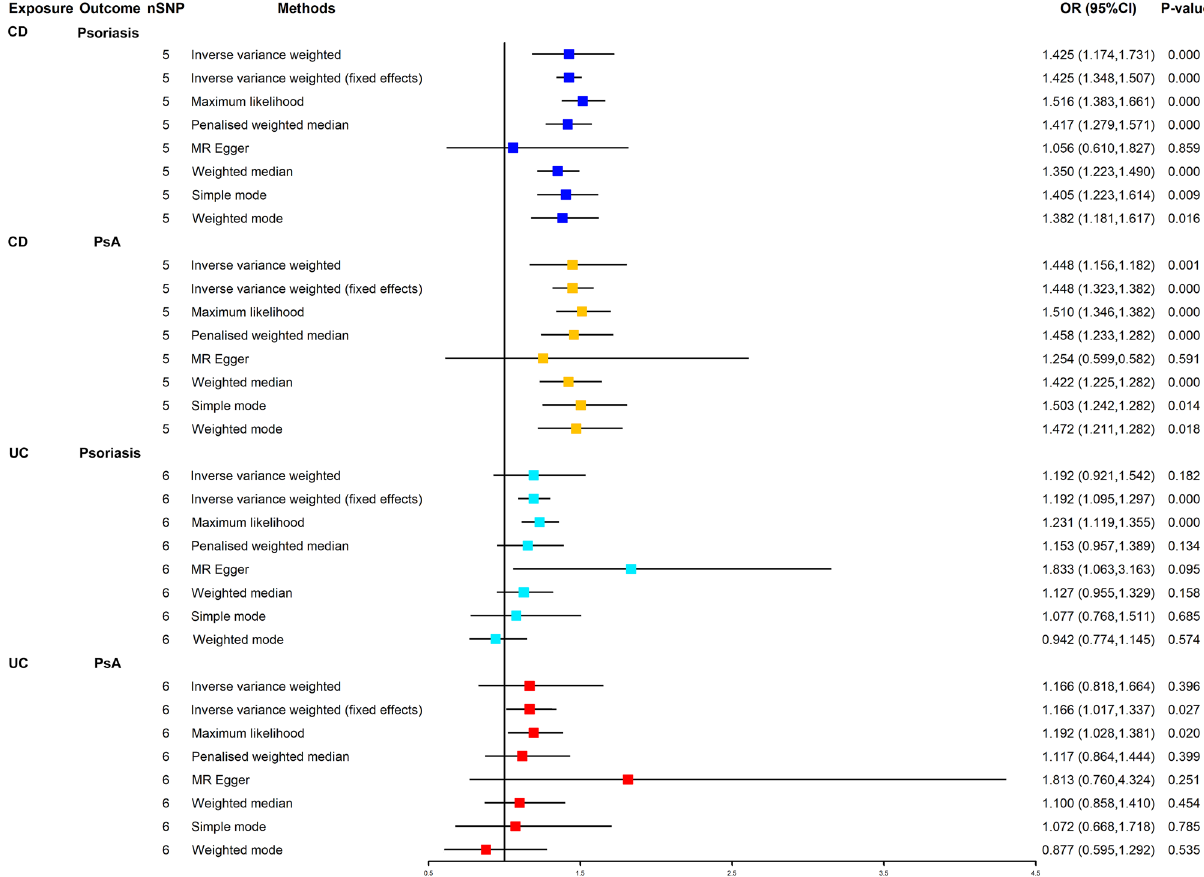
Figure 3. Forest plot for MR analyses of the causal effect of CD and UC on psoriasis and PsA. CD Crohn’s disease, UC ulcerative colitis, PsA psoriatic arthritis, nSNP number of single nucleotide